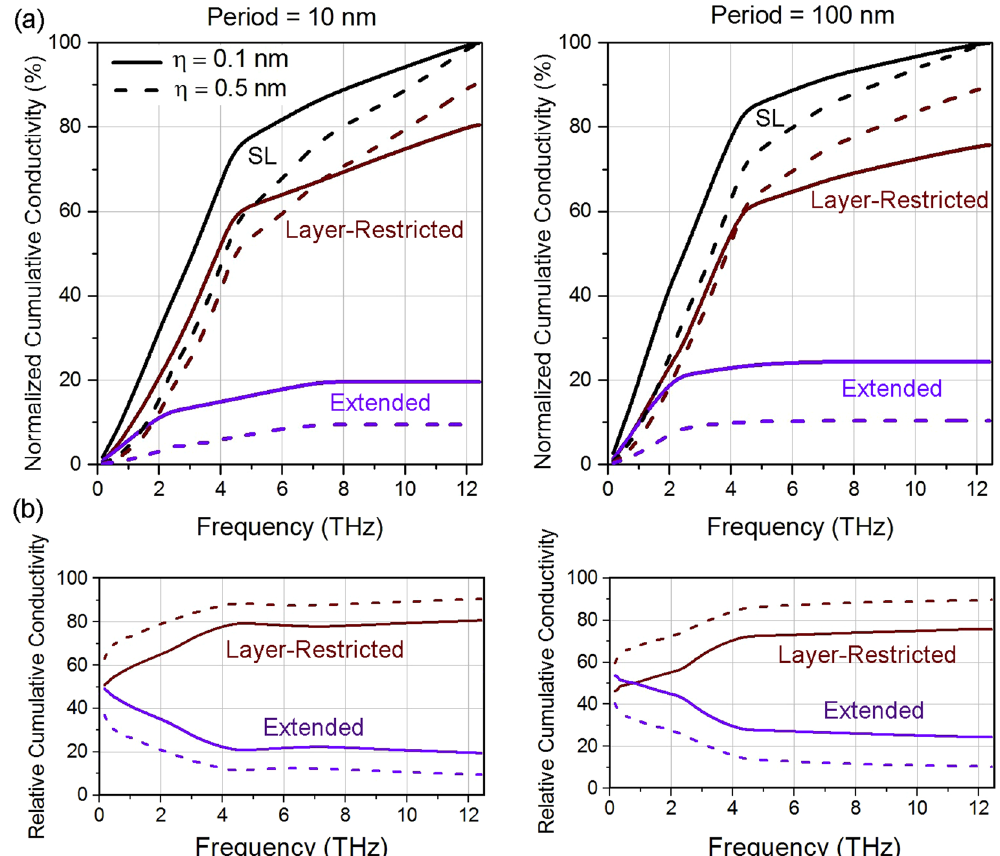
Figure 6. ( a ) Frequency spectrum for Si/Ge SL of period lengths d = 10 nm and d = 100 nm at roughness values of η = 0.1 nm and η = 0.5 nm (solid and dashed curves respectively). ( b ) Relative cumulative contribution of extended and layer-restricted phonons (purple and brown respectively) as a function of frequency in the corresponding